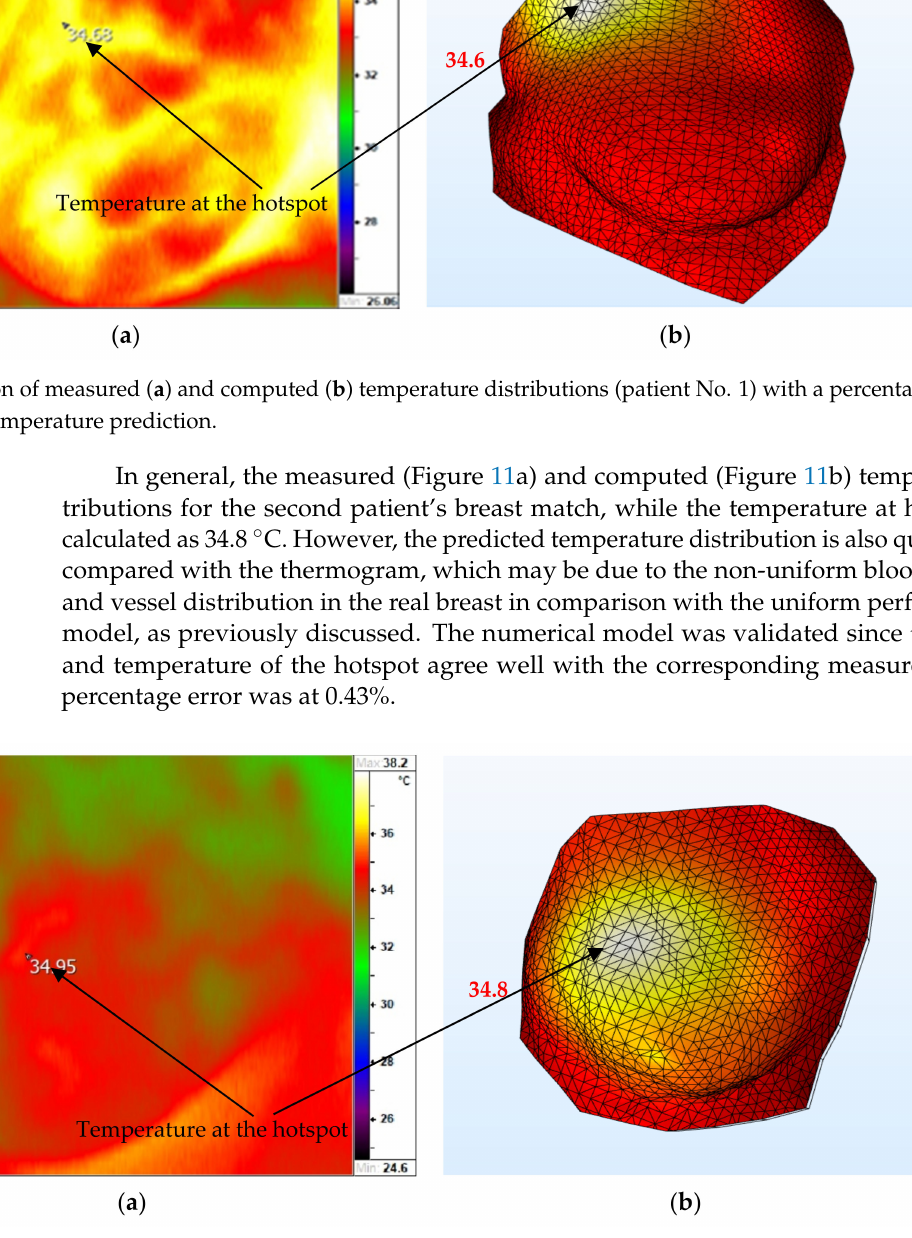
Figure 11. Comparison of measured ( a ) and computed ( b ) temperature distributions (patient No. 2) with a percentage error of 0.43% in hotspot temperature